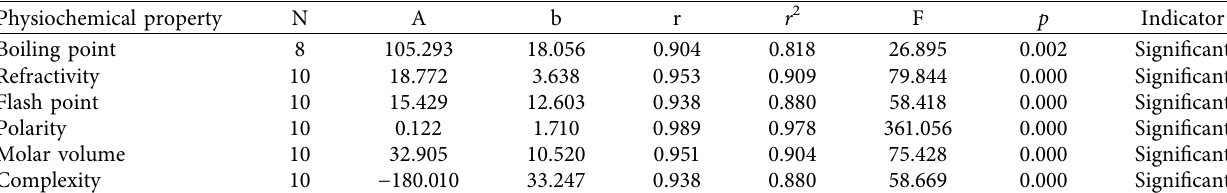
Table 5: Statistical parameters used in the QSPR model of S(G).